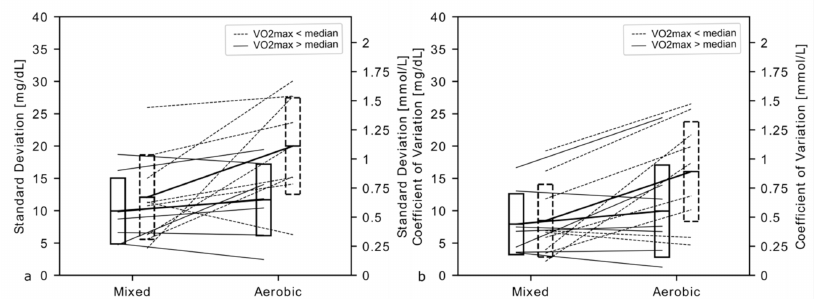
Figure 2. Effect of VO 2 max on glycemic variability during mixed and aerobic workout: ( a ) glucose standard deviation; and ( b ) coefficient of